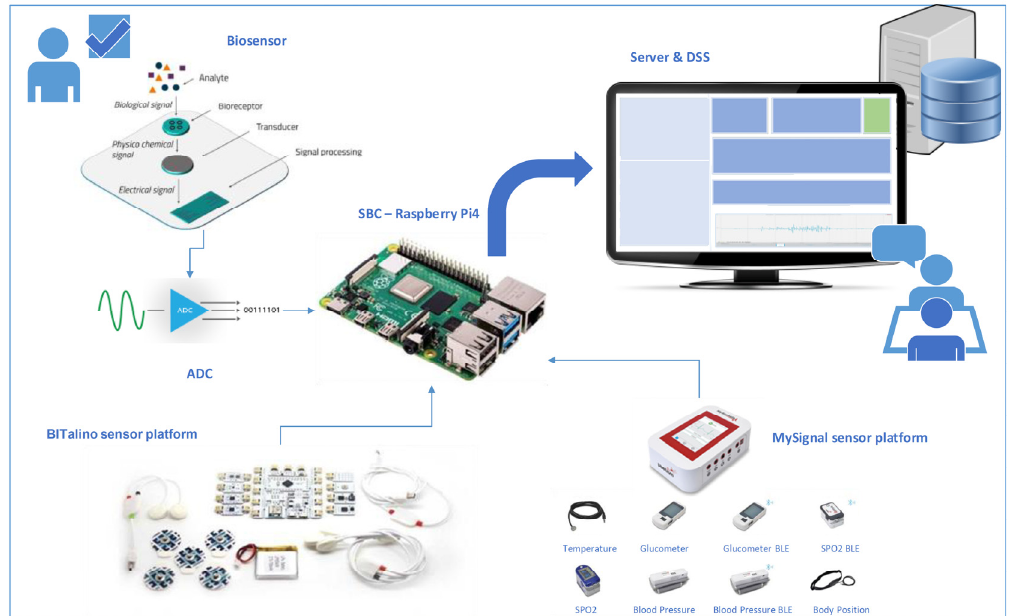
Figure 1. Integrated diagnostic layout for Parkinson’s disease monitoring.